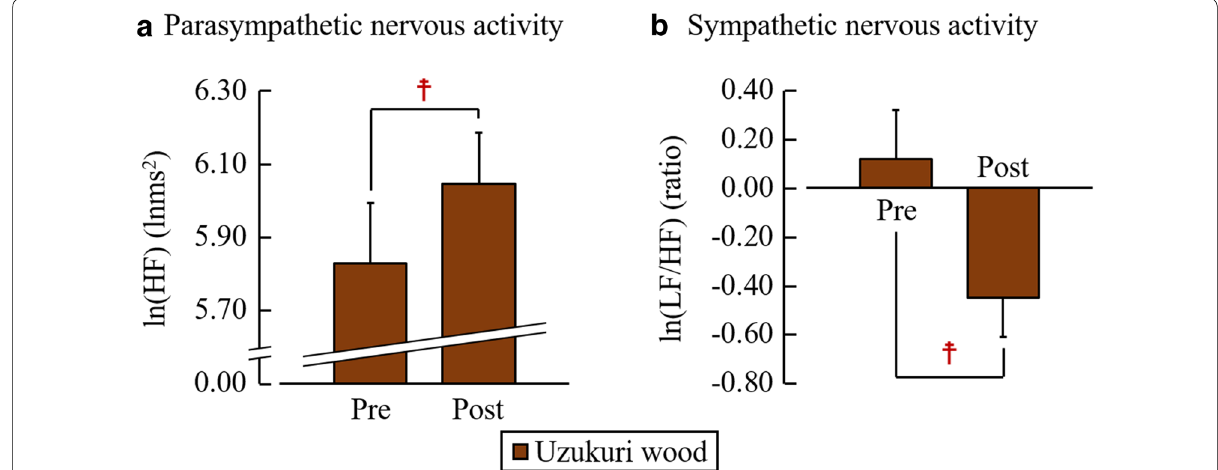
Fig. 6 Pre- and post-measurement values of contact with uzukuri wood via the soles of the feet of parasympathetic and sympathetic nervous activities. a The natural logarithm of the high frequency (HF) power component of the heart rate variability. n (pre-measurement vs. post-measurement value) as determined using a paired t-test. b The natural logarithm of the low frequency/high frequency (LF/HF) of heart rate variability. n 27, mean SE, † p < 0.05 (pre-measurement vs. post-measurement value) as determined using a paired = ±